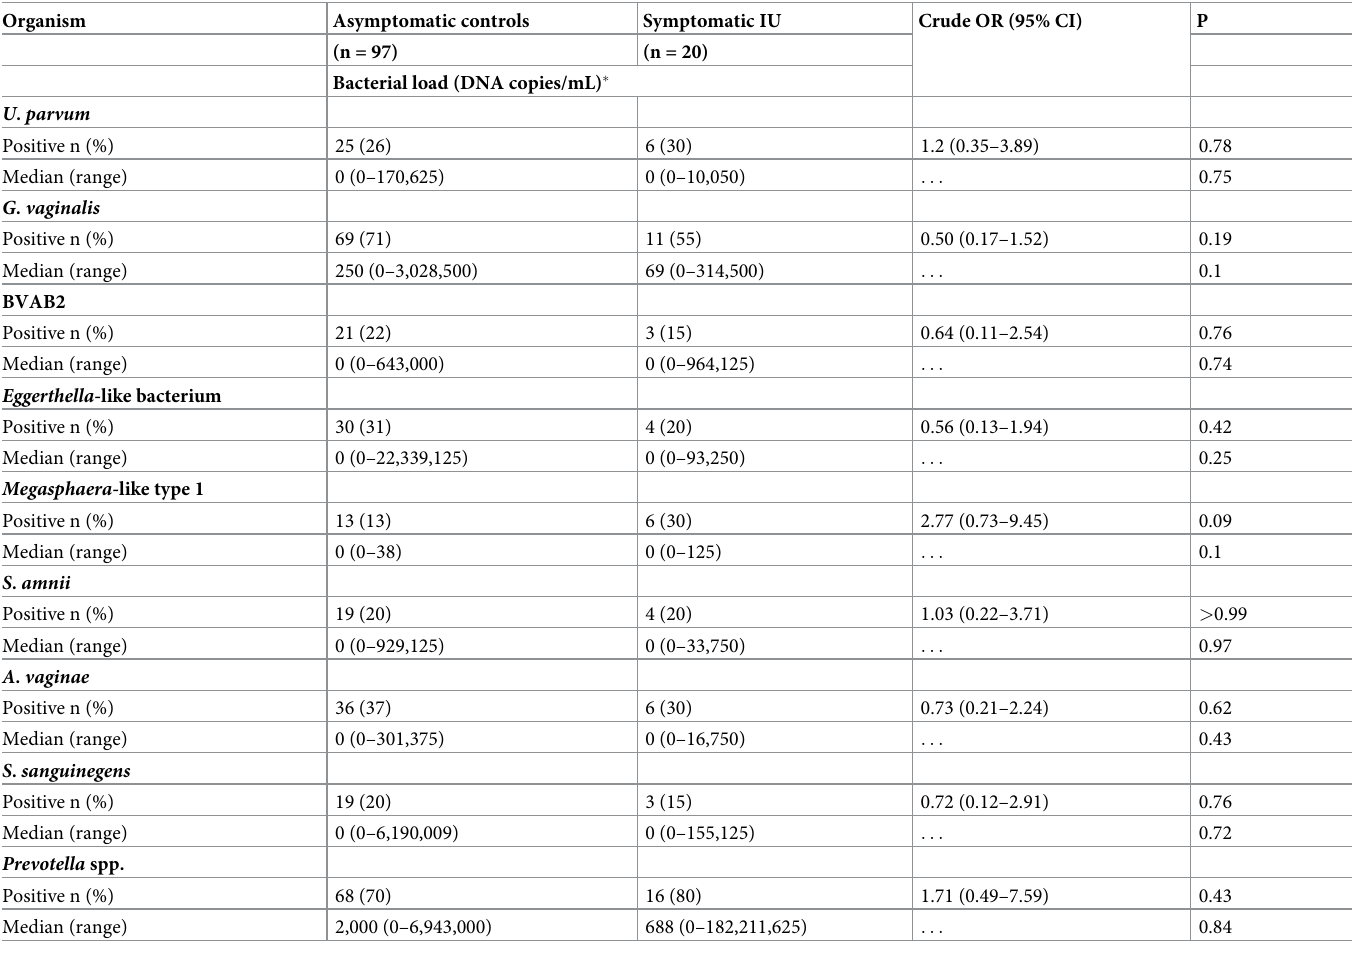
Table 2. Bacterial vaginosis associated bacteria and Ureaplasma parvum in asymptomatic male controls (n = 97) and in men with symptomatic idiopathic urethritis (n = 20). Symptomatic IU patients are negative for C . trachomati s, M . genitalium , HSV, adenovirus and U . urealyticum .